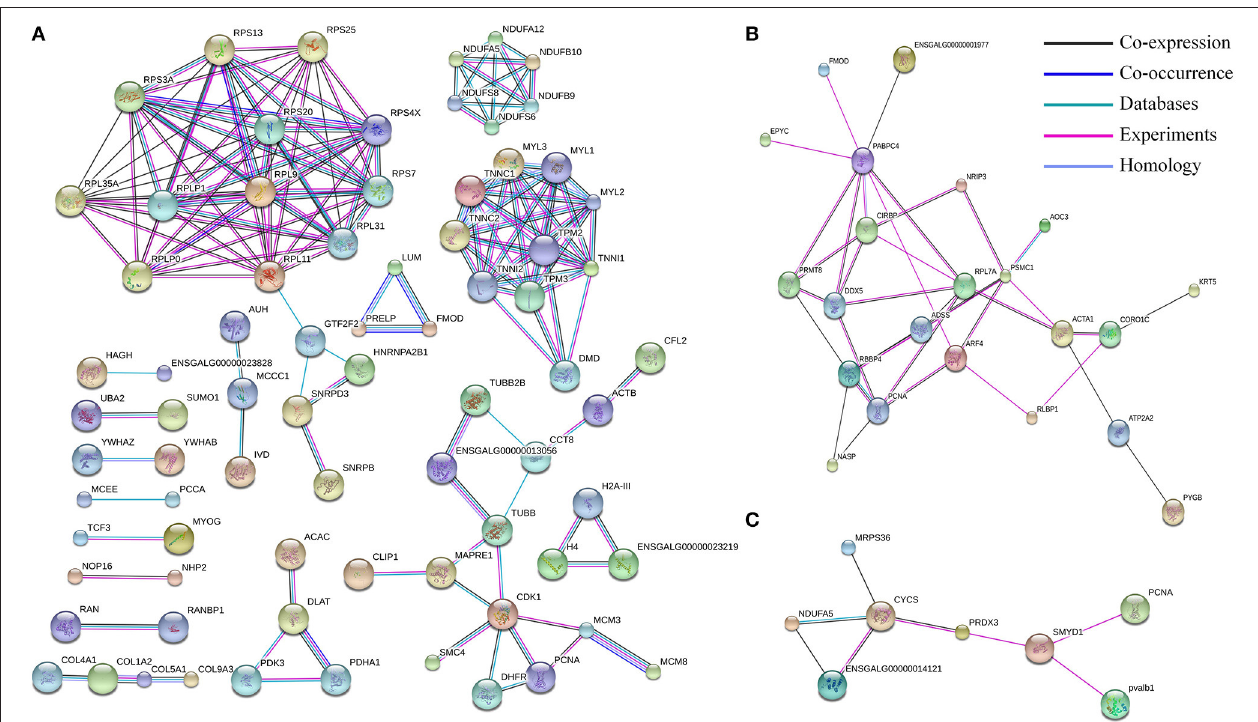
FIGURE 5 | The protein–protein interaction network of differentially expressed proteins in three comparisons: E11 vs. D1 (A), E11 vs. E16 (B) and E16 vs. D1 (C) . In this network, nodes represent proteins, and lines with different color represent the predicted different associations.